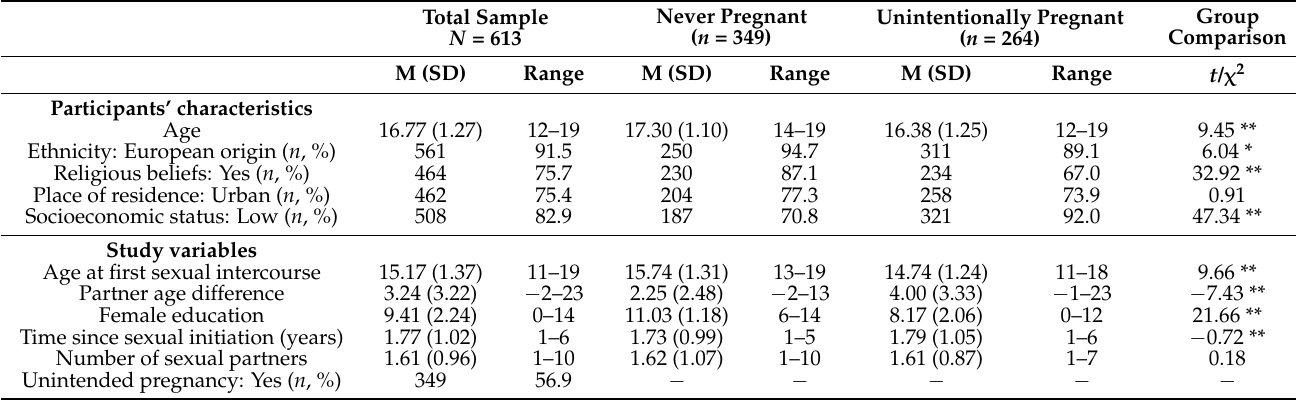
Table 1. Descriptive Statistics and Group